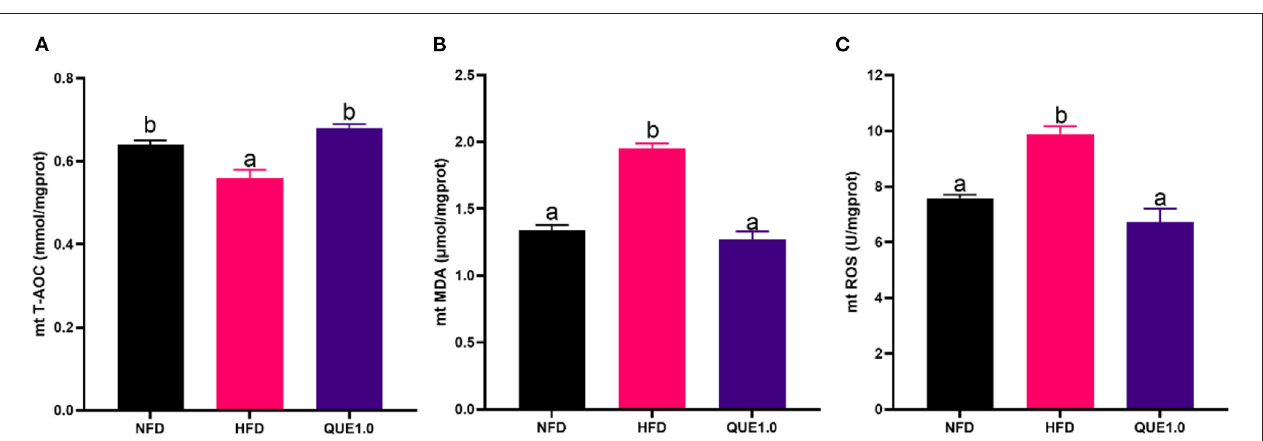
FIGURE 4 | Oxidative status in hepatic mitochondria of fish fed with experimental diets. (A) T-AOC. (B) MDA content. (C) ROS content. T-AOC, total antioxidant capacity; MDA, malondialdehyde. Different letters indicate a significant difference among groups ( P < 0.05).